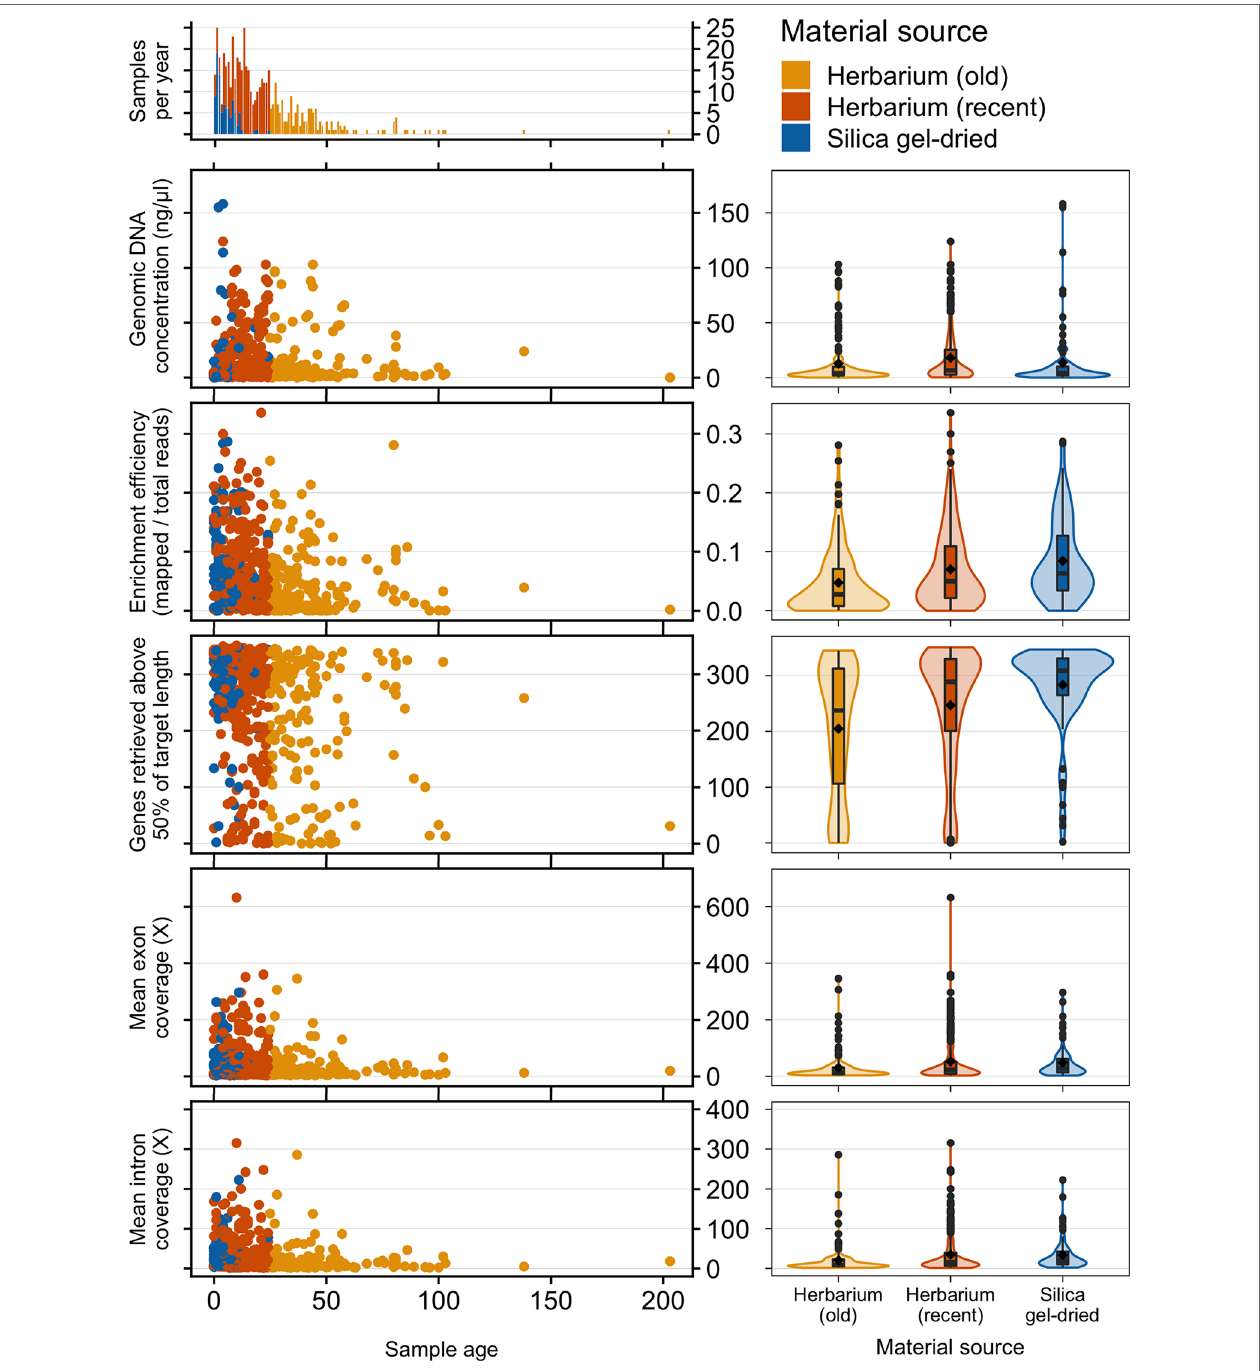
and median. The diamond symbol denotes the mean while circles represent outliers. The horizontal width of the plot shows the density of the data along the y